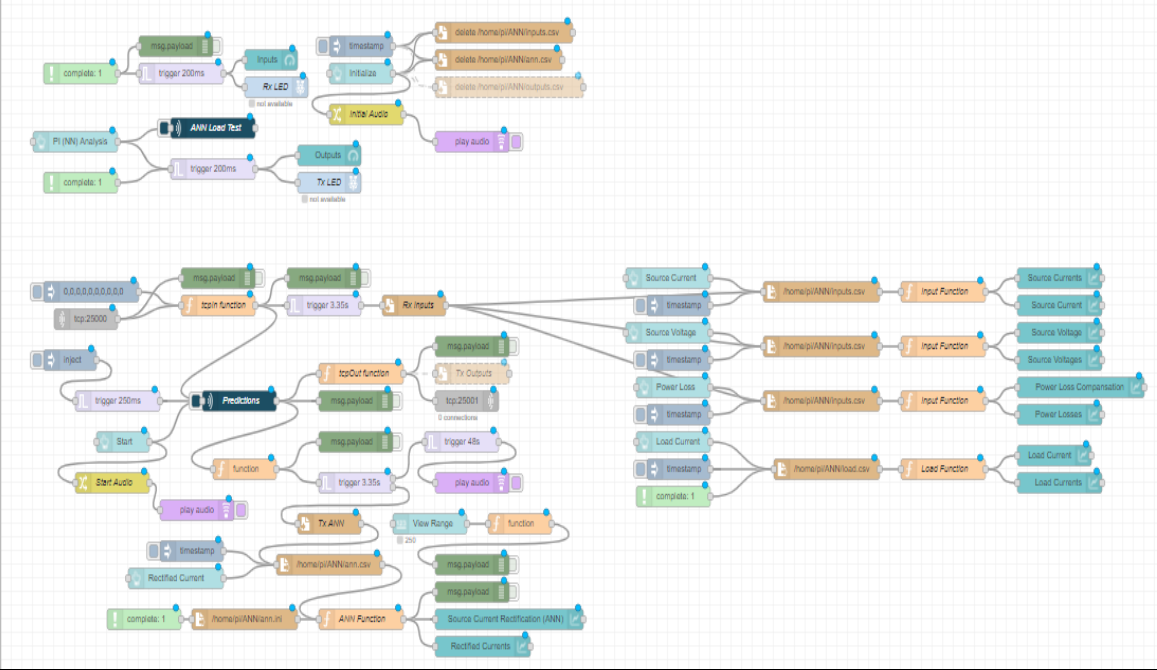
Figure 34. Backend for Supervisory Control of HMI.